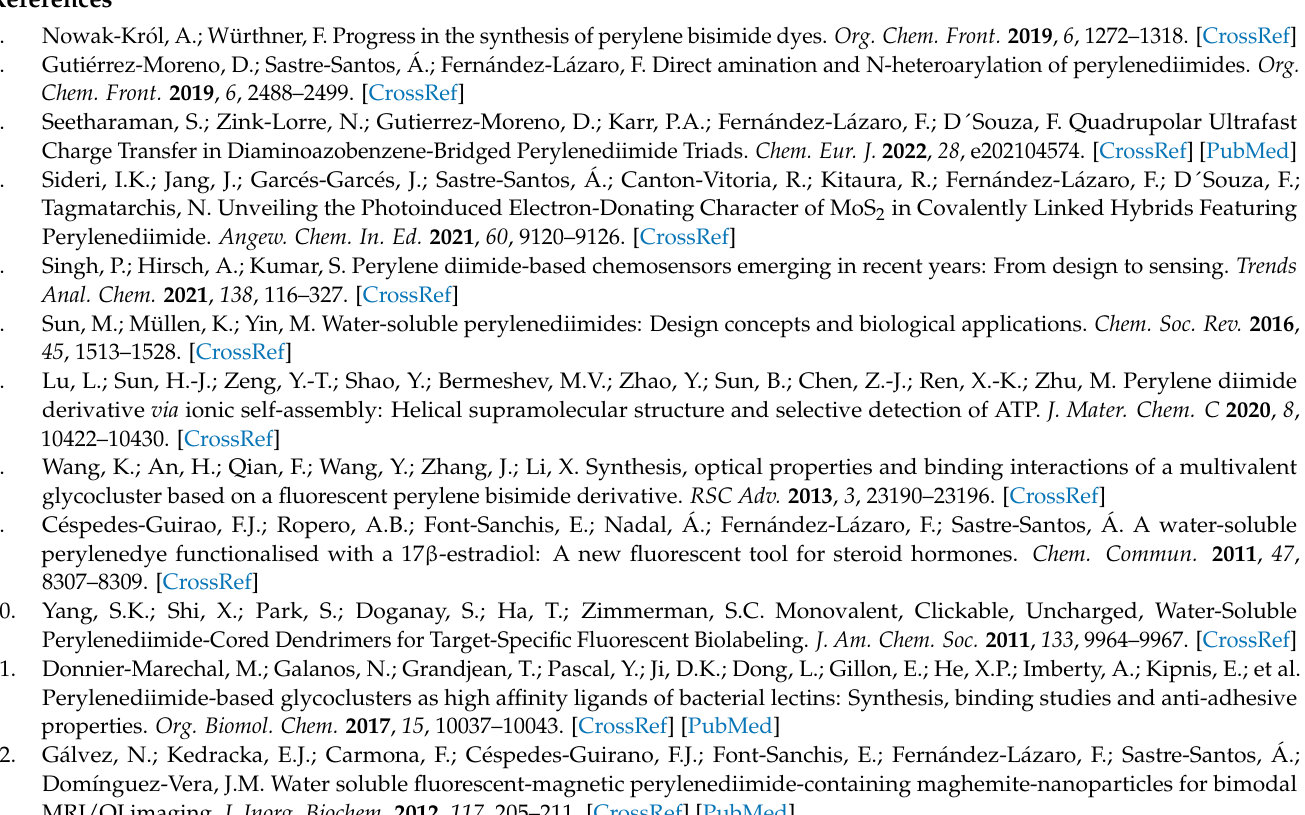
PDI-2. Figure S2: 13 C NMR spectrum of PDI-2. Figure S3: MALDI-TOF spectrum of PDI-2. Figure S4: UV-Vis and fluorescence spectra of PDI-2. Figure S5: IR spectrum (KBr) of PDI-2. Figure S6: 1 H NMR spectrum of PDI-6. Figure S7: 1 3 C NMR spectrum of PDI-6. Figure S8: MALDI-TOF spectrum of PDI-6. Figure S9: UV-Vis and fluorescence spectra of PDI-6. Figure S10: IR spectrum (KBr) of PDI-6. Figure S11: 1 H NMR spectrum of PDI-3. Figure S12: MALDI-TOF spectrum of PDI-3. Figure S13: IR spectrum (KBr) of PDI-3. Figure S14: 1 H NMR spectrum of PDI-4. Figure S15: MALDI-TOF spectrum of PDI-4. Figure S16: IR spectrum (KBr) of PDI-4. Figure S17: 1 H NMR spectrum of PDI-7. Figure S18: IR spectrum (KBr) of PDI-7. Figure S19: 1 H NMR spectrum of PDI-8. Figure S20: IR spectrum (KBr) of PDI-8. Figure S21: UV-Vis spectra of PDI-complexes. Figure S22: Fluorescence spectra of PDI-3 and PDI-4. Figure S23: UV-Vis spectra of PDI-2, -3, -7, -8 in PBS solution + 5% DMSO at 37.5 ◦ C, at 0 and 24 h. Figure S24: Dose–response curves of HeLa cells after incubation with cationic PDI-2, -3, -4, and PDI-6, -7, -8 for 24